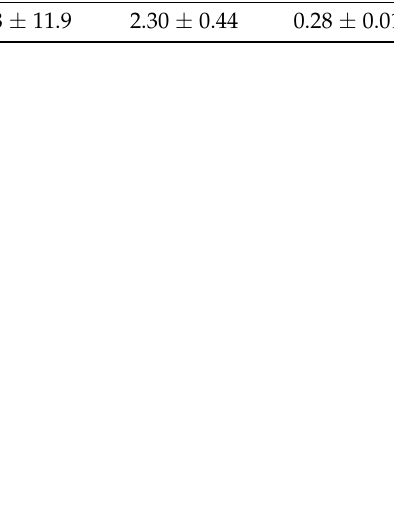
Figure 6. SEM photomicrograph of albendazole nanoparticles (×100,000). Table 1. Optimization formulation condition and properties of ABZ nanocrystal.